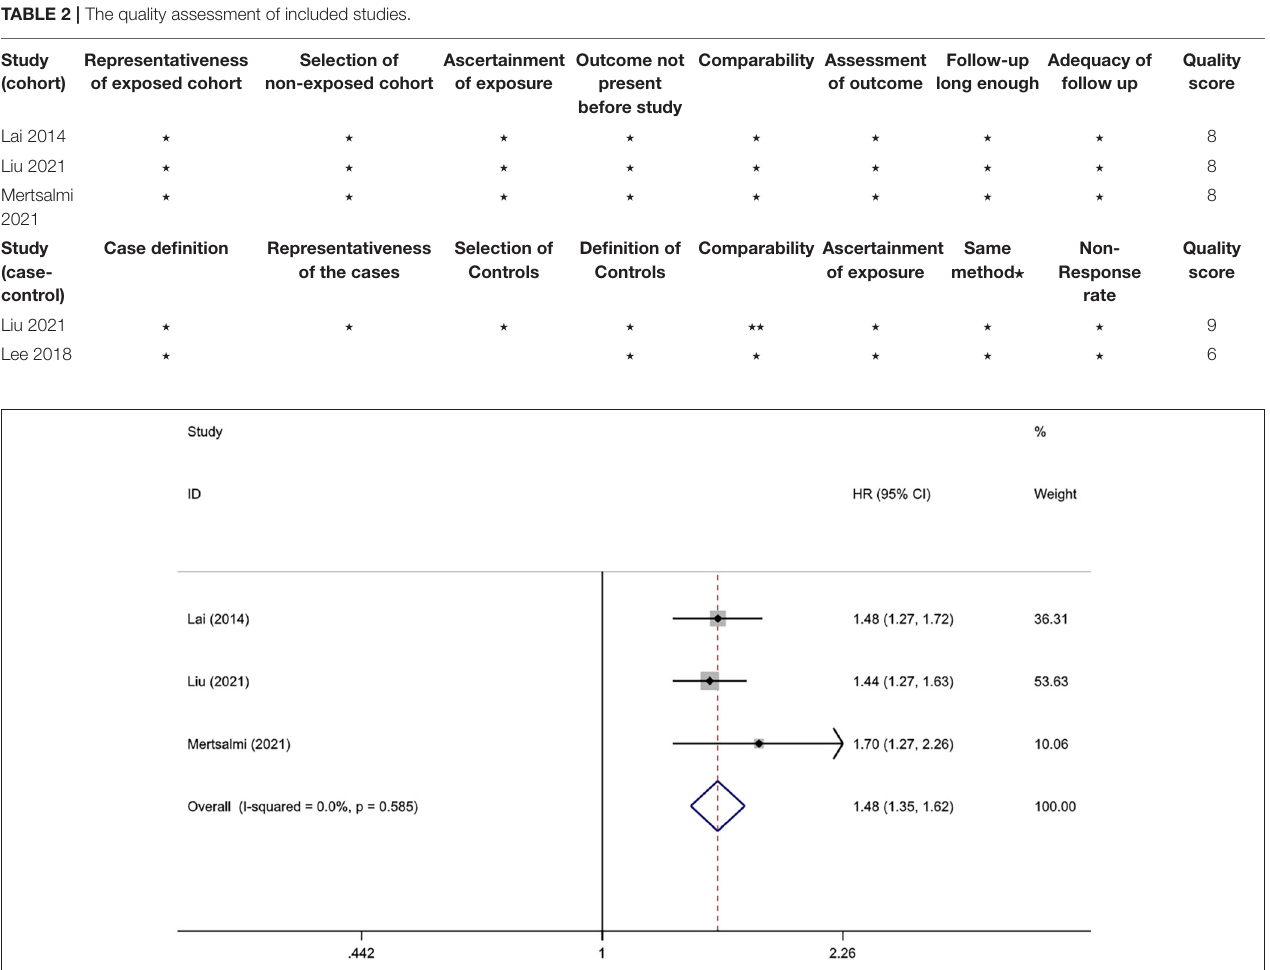
FIGURE 2 | Forest plot of the associations between irritable bowel syndrome and risks of Parkinson’s disease.